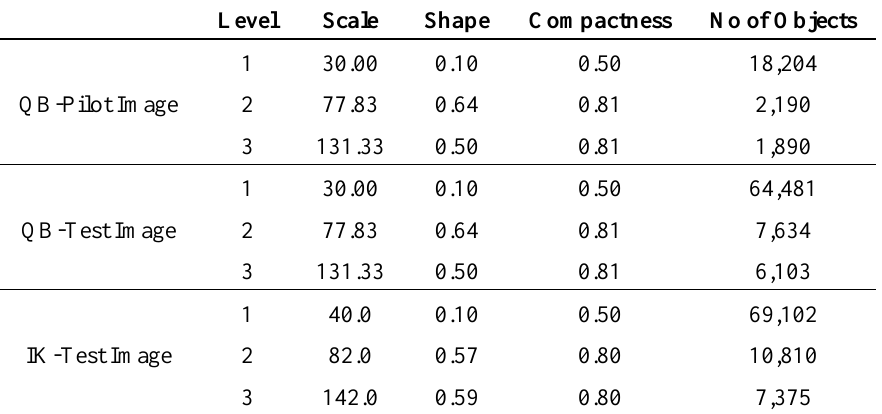
Table 2. Multi-resolution segmentation parameters for the three images.